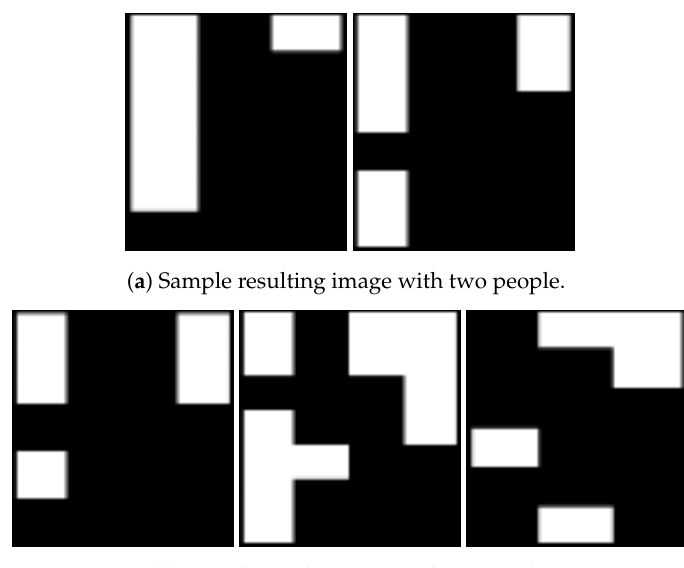
Figure 11. Resized RoIs as binary images.